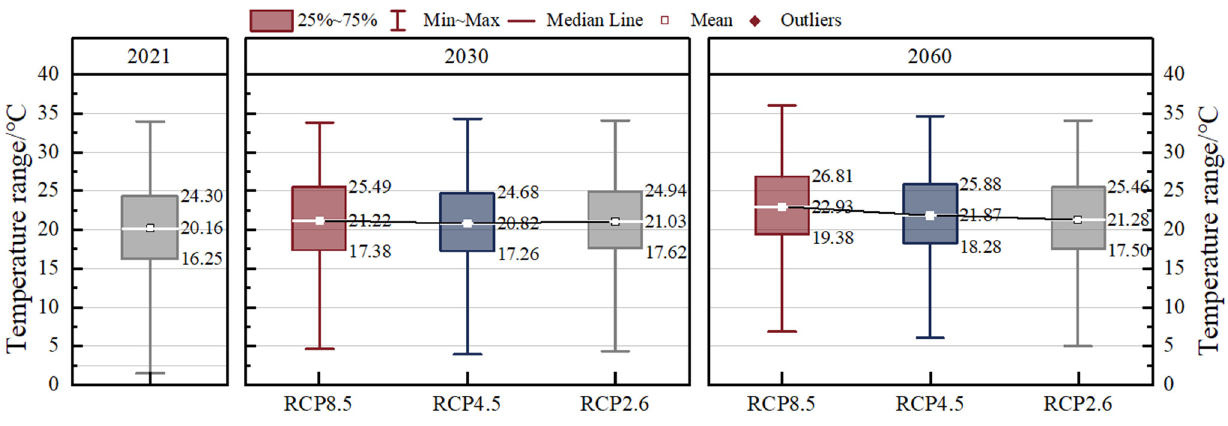
Figure 13. Outdoor temperature in different carbon emission scenarios in Changchun during sum- mertime (May to September) in 2021, 2030, and 2060.